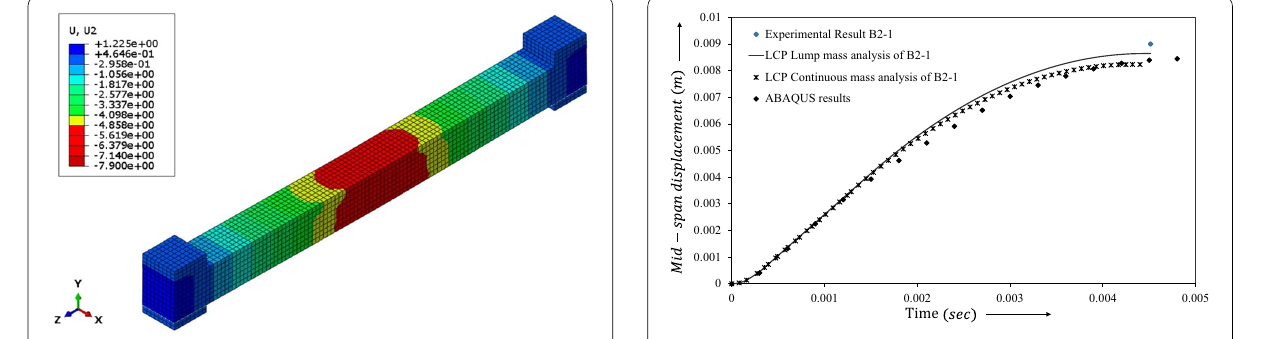
Fig. 27 Maximum deflections of ABAQUS beam (units in mm).